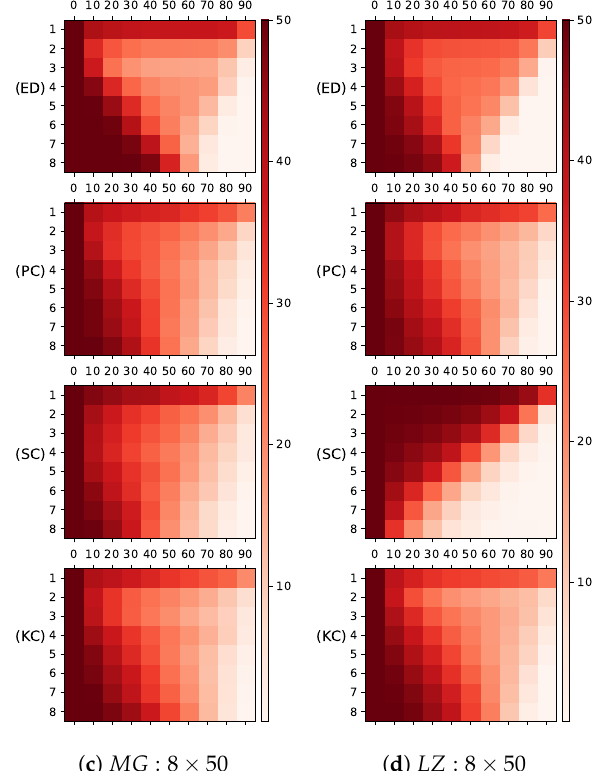
Figure 7. The figure shows the number of neurons remaining in each layer of DeepESN, pruned by different similarity estimation criterion-based NS-IPMA methods. The vertical axis indicates the layer index, the horizontal axis indicates the percent of pruned neurons in the initial total number of neurons, the mesh color indicates the number of remaining neurons, and the darker color indicates more neurons remaining. ( a ): Initial 4 layer reservoirs with 100 neurons in each reservoir on MG dataset; ( b ): Initial 8 layer reservoirs with 50 neurons in each reservoir on MG dataset; ( c ): Initial 4 layer reservoirs with 100 neurons in each reservoir on LZ dataset; ( d ): Initial 8 layer reservoirs with 50 neurons in each reservoir on LZ